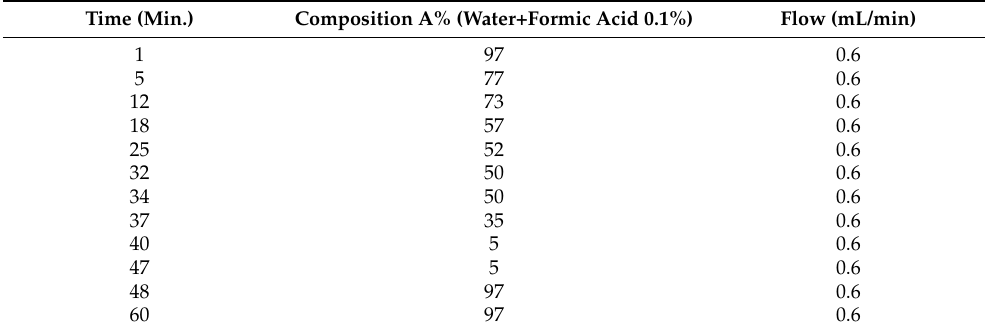
Table 3. Gradient elution conditions of the HPLC-DAD analyses for the identification and quantifica- tion of polyphenolic compounds.